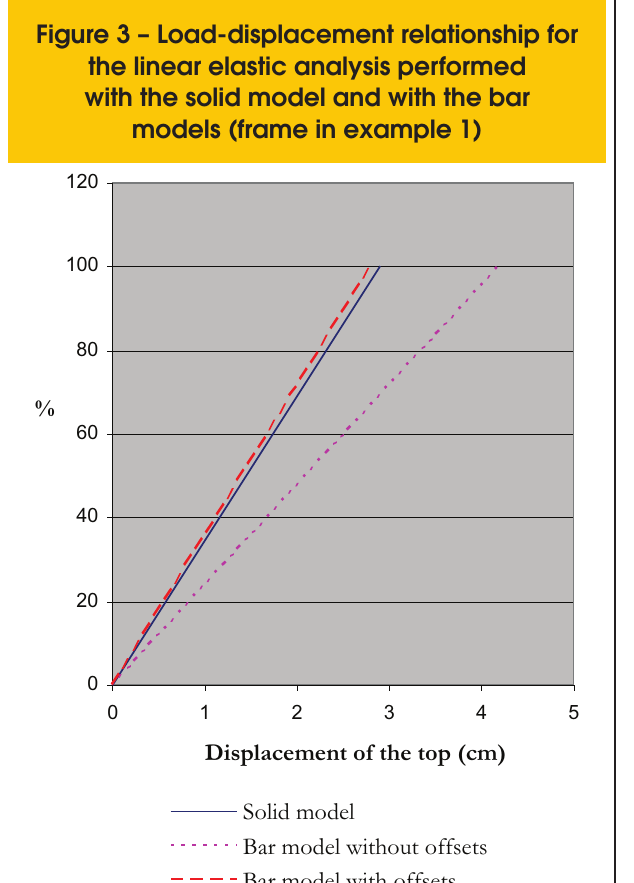
Figure 3 – Load-displacement relationship for the linear elastic analysis performed with the solid model and with the bar